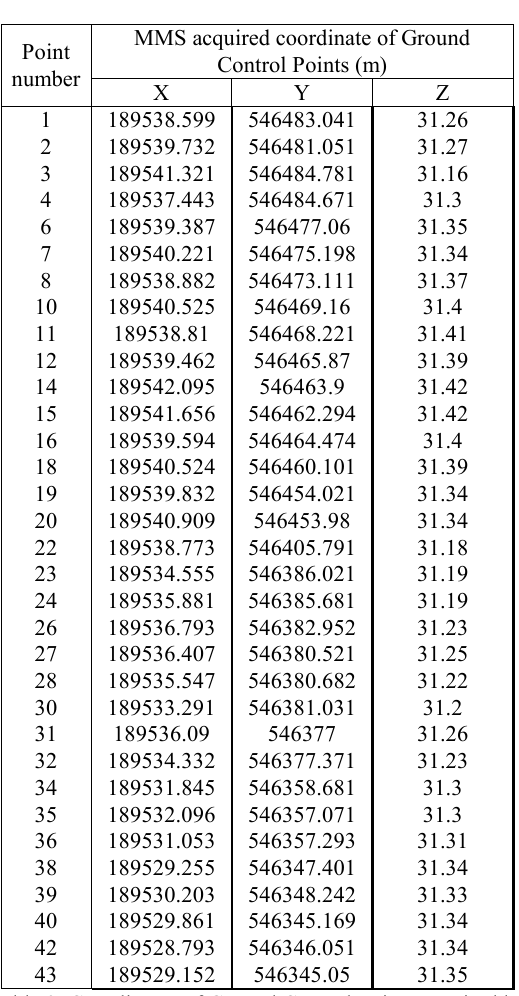
Table 2. Coordinates of Ground Control Points acquired by MMS device Table 3 below shows the coordinates of 10 checkpoints obtained by GNSS.